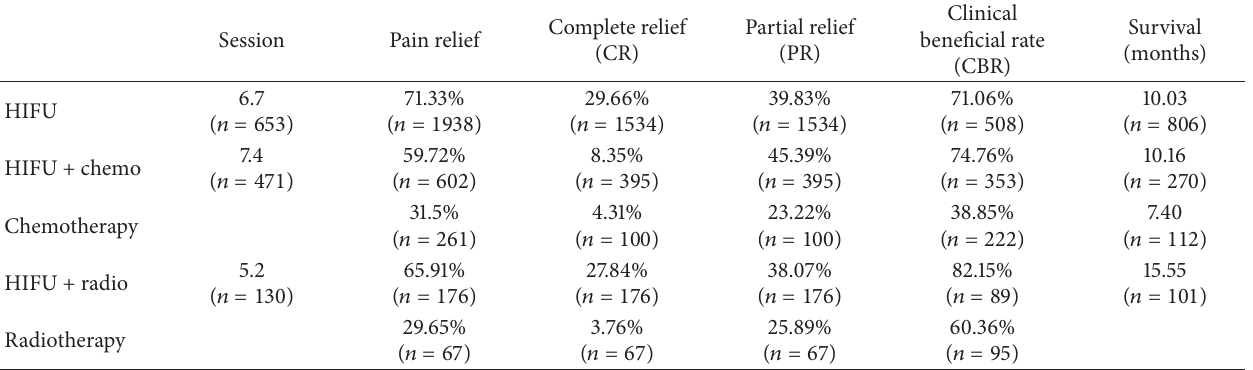
Table 2: Statistics of the number of sessions, pain relief, clinical benefit rate, and survival of advanced pancreatic cancer patients undergoing HIFU therapy or in conjunction with chemotherapy or